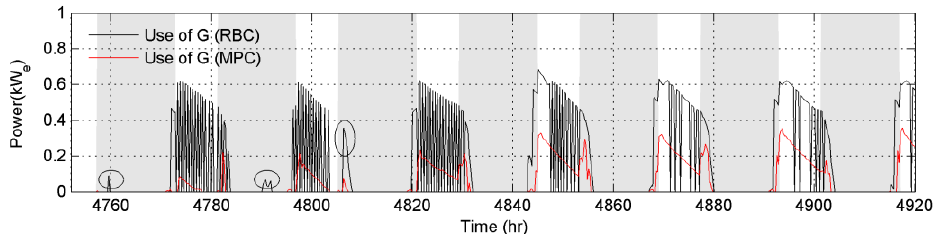
Figure 11. Electricity from the power grid (G) used to cover the weekly cooling demand of the building. Comparison between RBC and MPC (OFG, PH of 18 h).